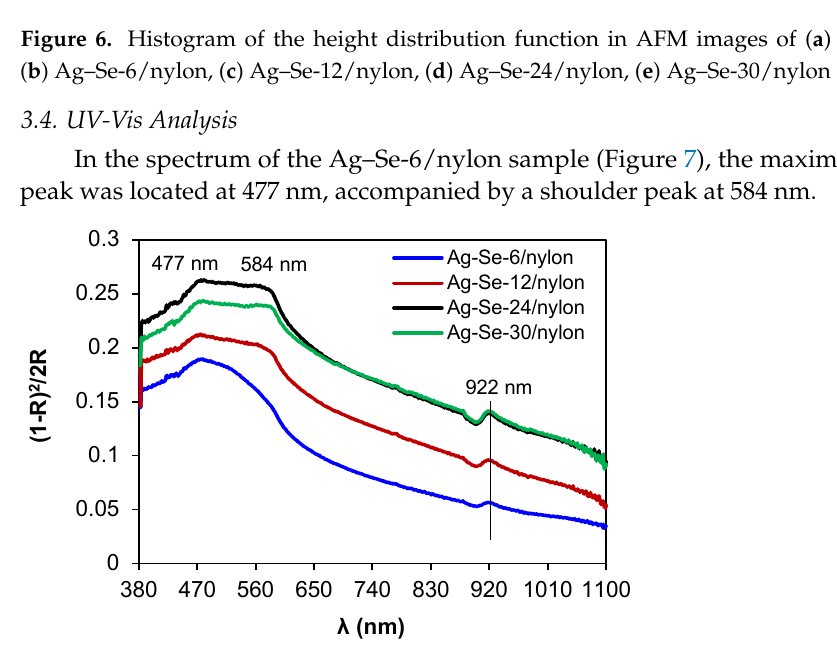
Figure 7. Optical absorption spectra of Ag–Se/nylon nanocomposites.